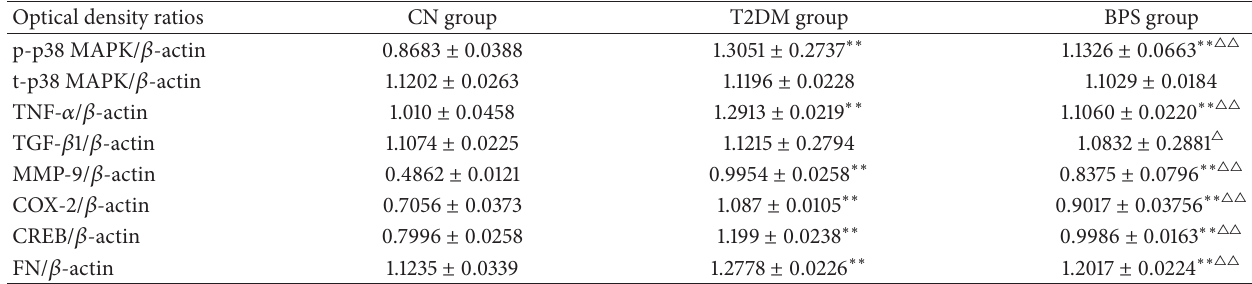
Table 8: Western blot results of p-p38, t-p38, TNF- 𝛼 , TGF- 𝛽 1, MMP-9, COX-2, CREB, and FN in kidney tissues of rats in experiment ( 𝑛 = 6 , 𝑋 ± 𝑆 ).